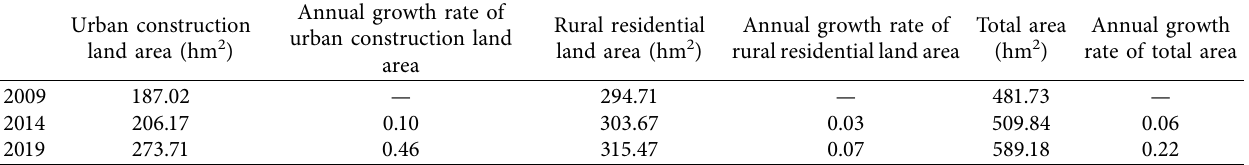
Table 2: Summary of changes in the construction land area of Ciyutuo Subdistrict.